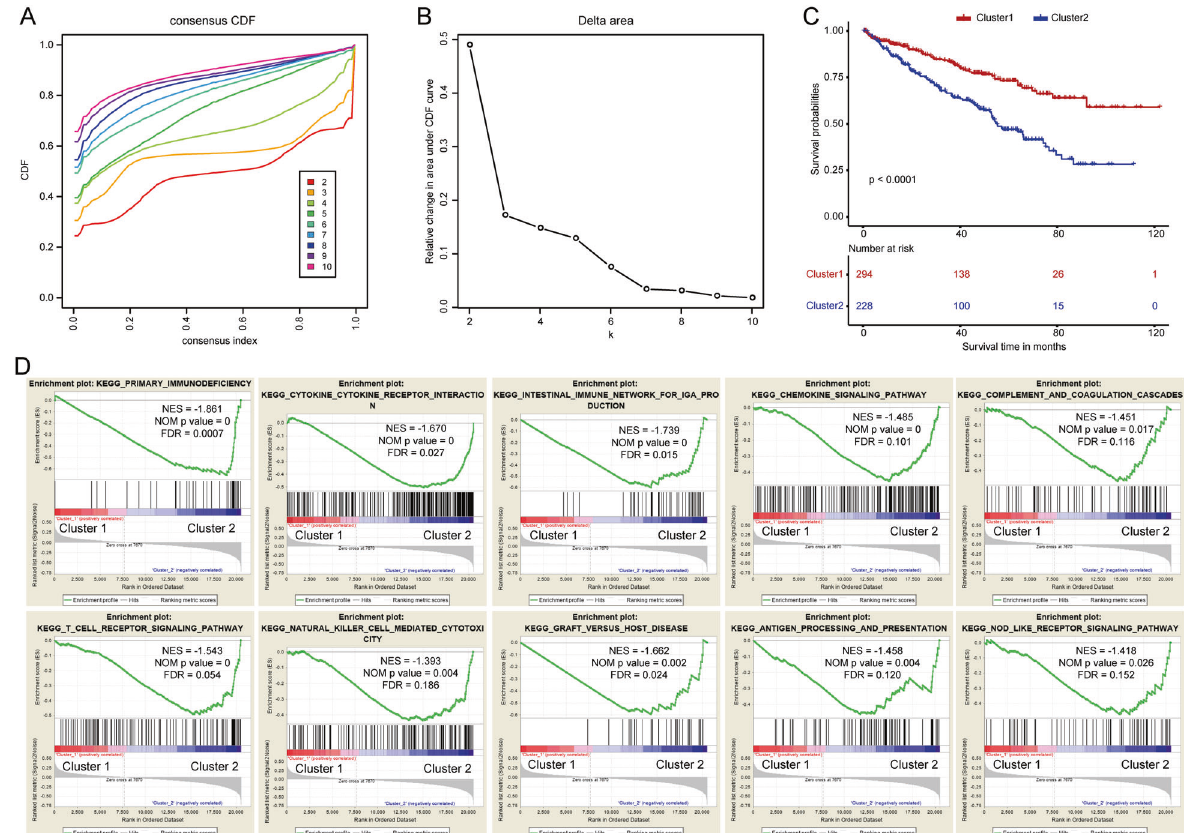
Fig. 3 Consensus clustering based on the 13 costimulatory molecule genes. A Consensus clustering cumulative distribution function (CDF) for k = 2 to k = 10. B The relative change in area under the CDF curve for k = 2 to k = 10. C Kaplan – Meier curve for two clusters of clear cell renal cell carcinoma. D The gene set enrichment analysis showed that several immune-related pathways were signi fi cantly enriched in cluster 2.